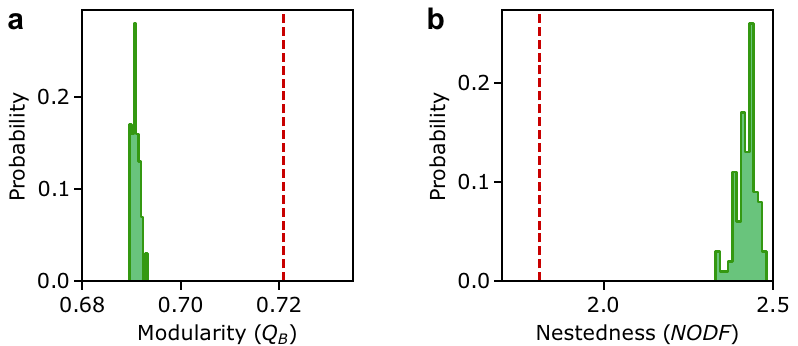
Figure 3. Nestedness and modularity in the photobiont-mycobiont network. Here we show ( a ) modularity denoted as Q B and ( b ) nestedness calculated as the full network NODF (see “Materials and methods”). The empirical values are shown as vertical red dashed lines, while bootstrap null model distributions are shown as a histogram of probability density obtained from 100 independent randomizations of the network.